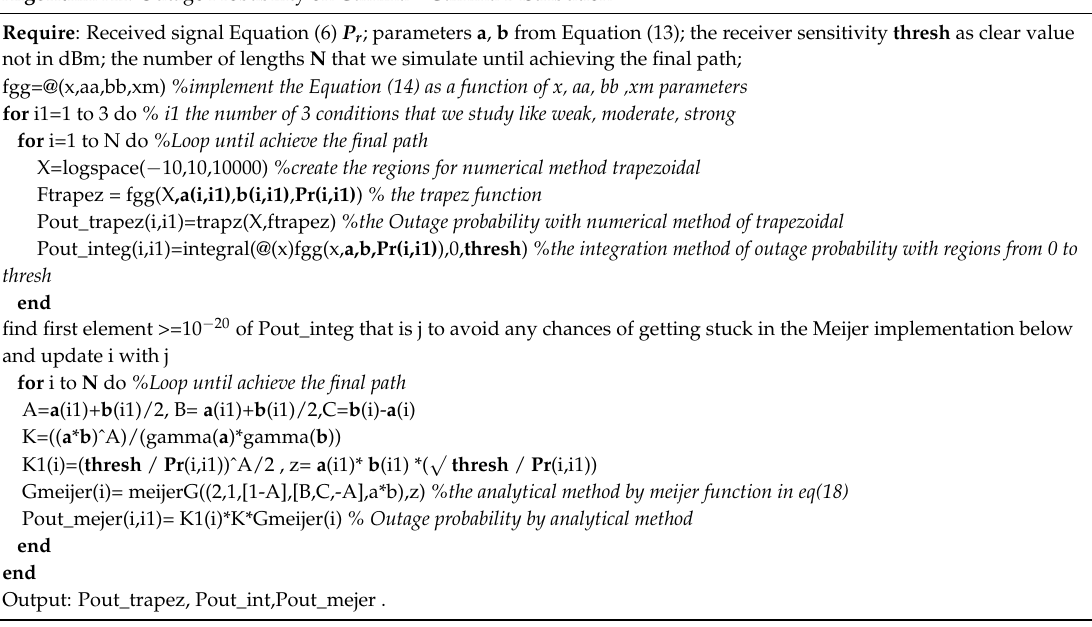
Algorithm A1. Outage Probability on Gamma—Gamma